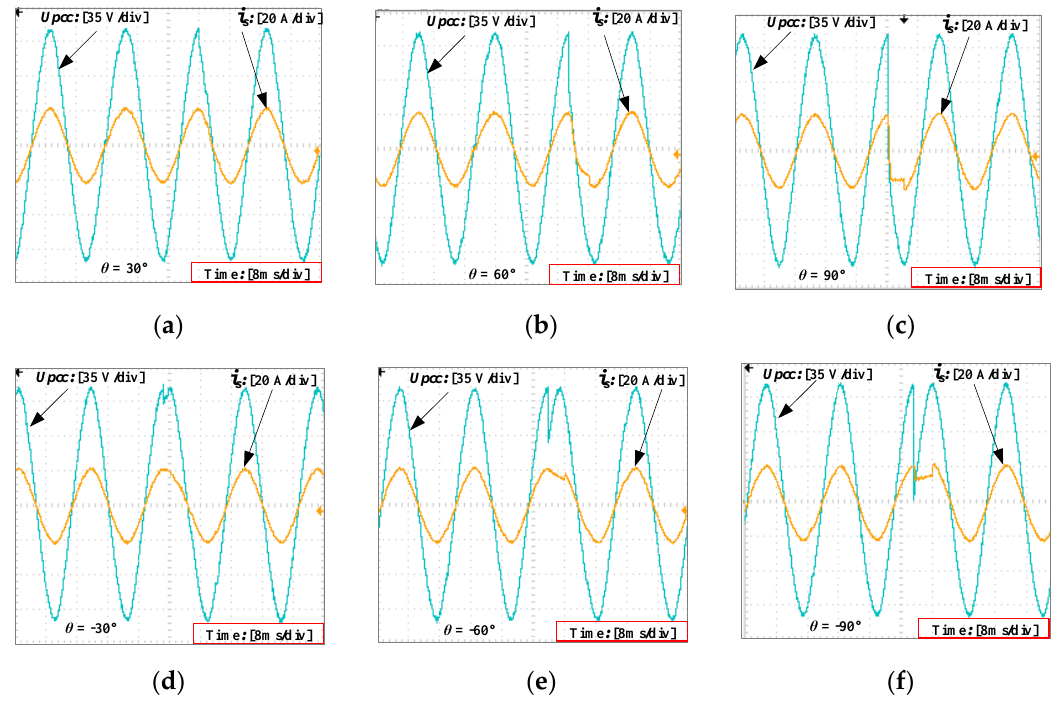
Figure 17. Waveforms of U PCC and i s with U PCC suddenly dropping from 113 V to 85 V when Z g = 1.8 mH.